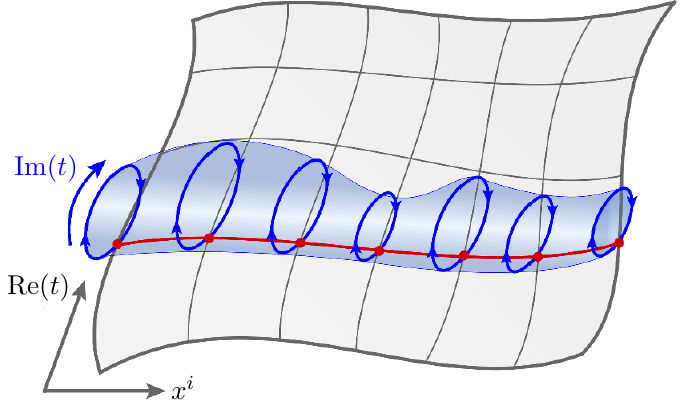
Figure 2 . Illustration of the spacetime picture associated with the proposed KMS gauge invariance, with the (cid:12)gure taken from [6]. We upgrade the spacetime manifold (a Lorentzian geometry, depicted in gray, with a typical Cauchy slice indicated in red), on which our quantum system resides to a thermal (cid:12)bre bundle. We further assume local thermal equilibrium (as in, e.g., hydrodynamics) at each spacetime point which guarantees existence of a thermal vector (cid:12) (cid:22) . We draw this vector (cid:12)eld as a circle (cid:12)bration with a thermal circle whose size is set by the local temperature. The KMS transformations we seek implement equivariance with respect to thermal translations along this local imaginary time circle. Restricting to a gauge slice corresponds to picking a Lorentzian section of this (cid:12)bration. Note that the size of the thermal circle is exaggerated; our arguments assume the high temperature limit where the size of the thermal circle is much smaller than the (cid:13)uctuation scale. lations along the thermal circle; operators are Lie dragged along the thermal vector (cid:12) (cid:22) consistent with their tensorial structure. The full algebra is presented in appendix